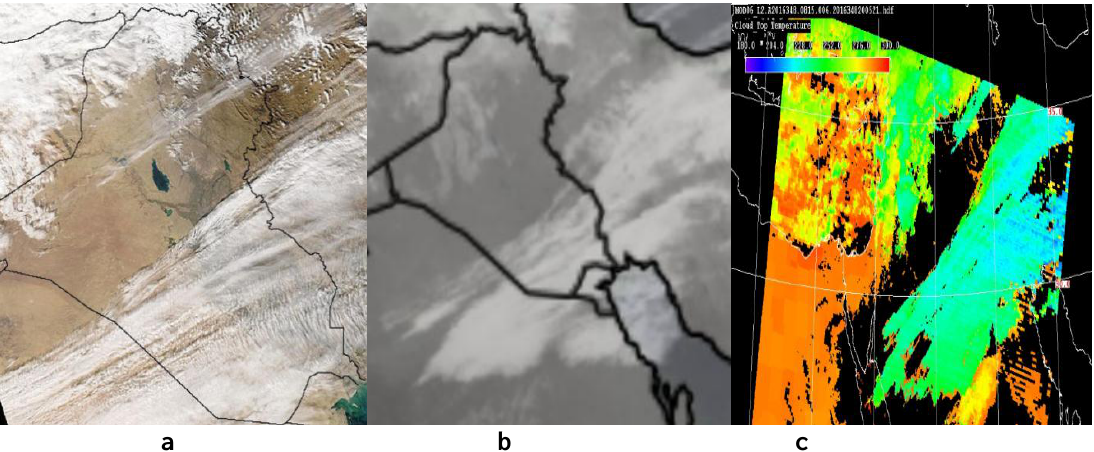
Fig. 5: a. Visible terra Modis satellite image over Iraq in 13/12/2016, b. infrared satellite image taken by goes satellite, c. Modis cloud top temperature mask band (31,